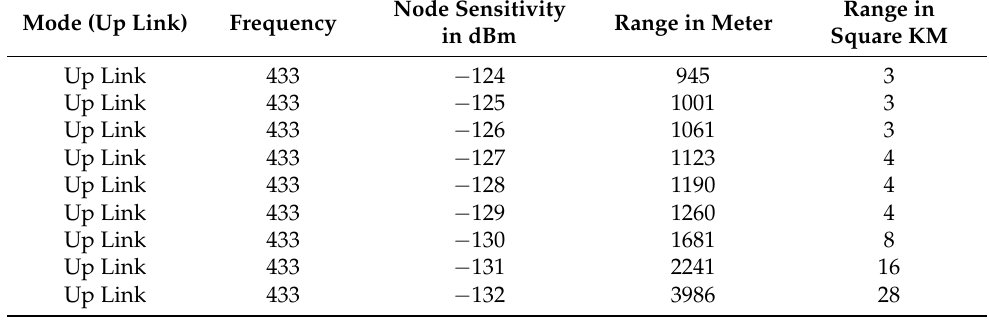
Table 8. Range for the node sensitivity from − 124 to − 132 dBm.